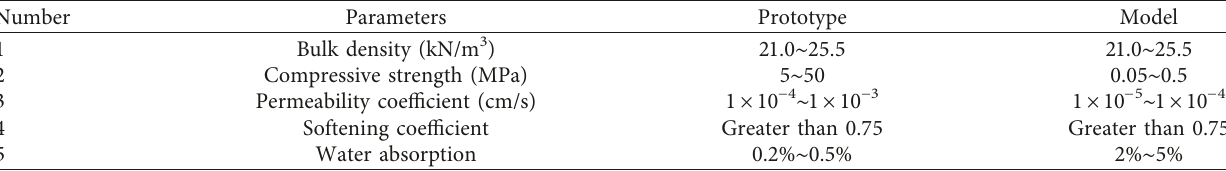
Table 3: Physical and mechanical parameters of the prototype and the model.